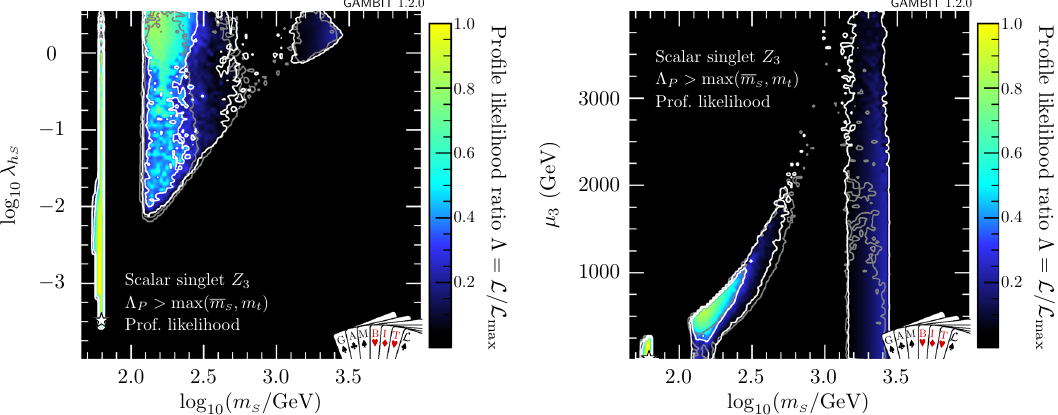
Fig. 8 Profile likelihoods for the Z 3 scalar singlet model, with the requirement that Λ P > max ( m S , m t ) only. Results are shown in the μ λ h S – m S (left) and in the 3 – m S (right) planes. Contour lines indicate 1 σ and 2 σ confidence regions, and best fit points are indicated with